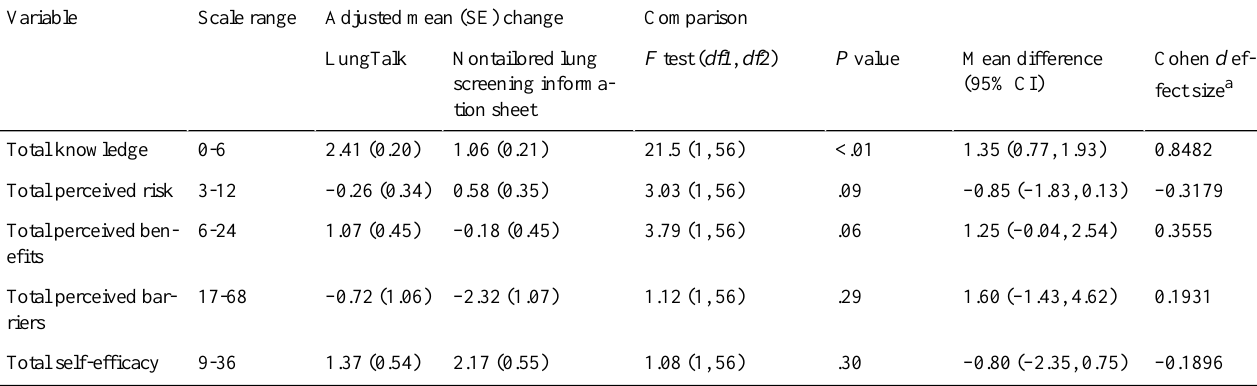
Table 3. Effect sizes.